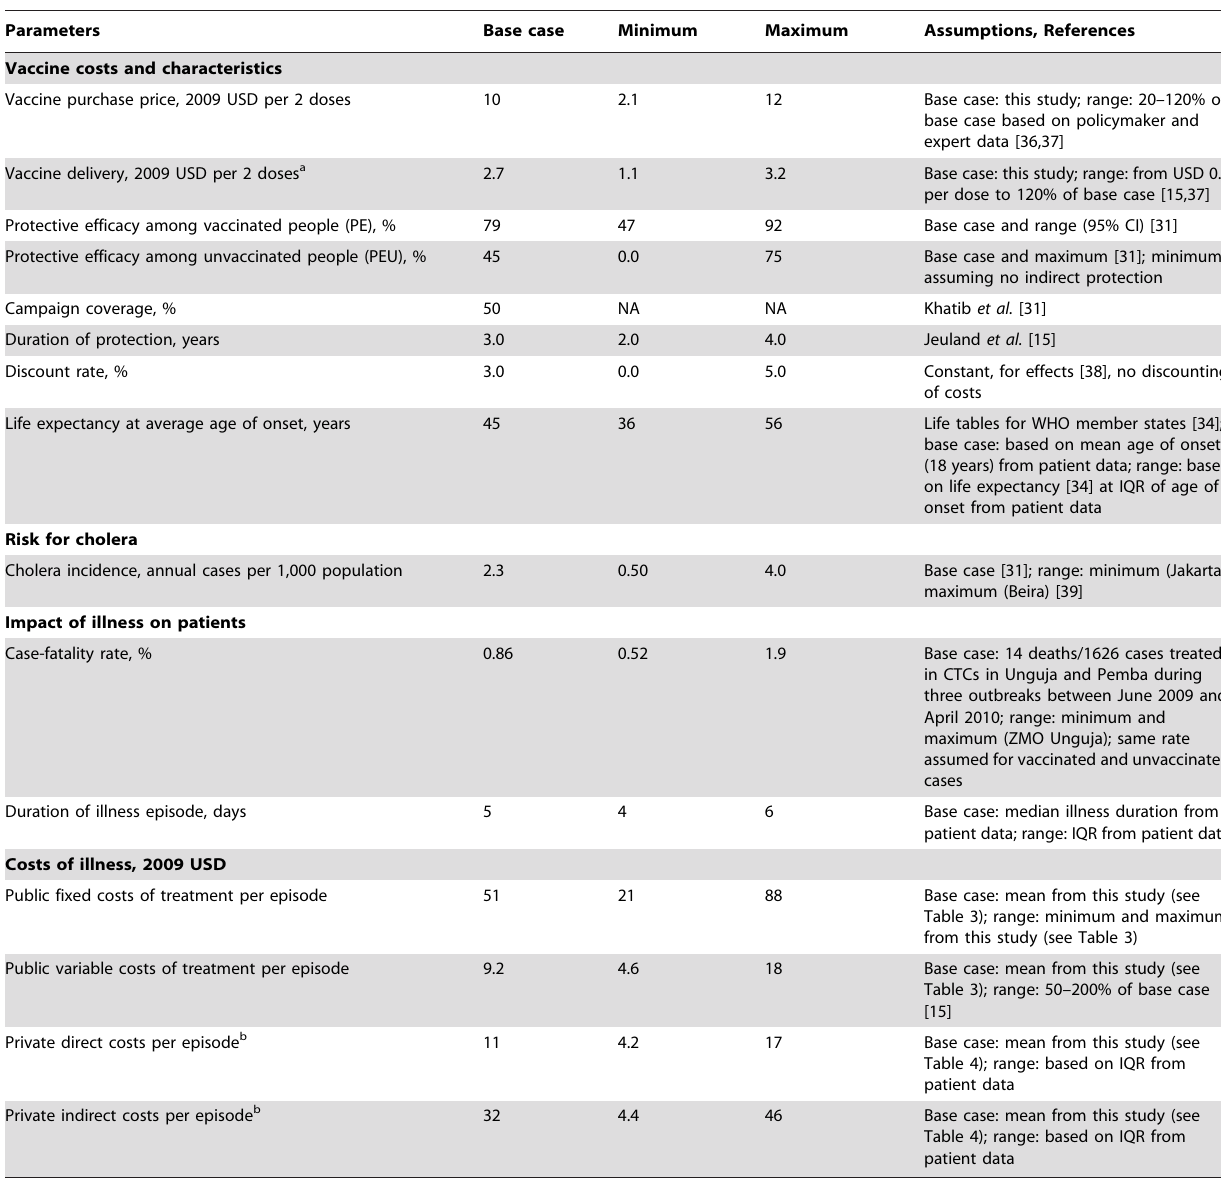
Table 2. Model input parameters with plausible